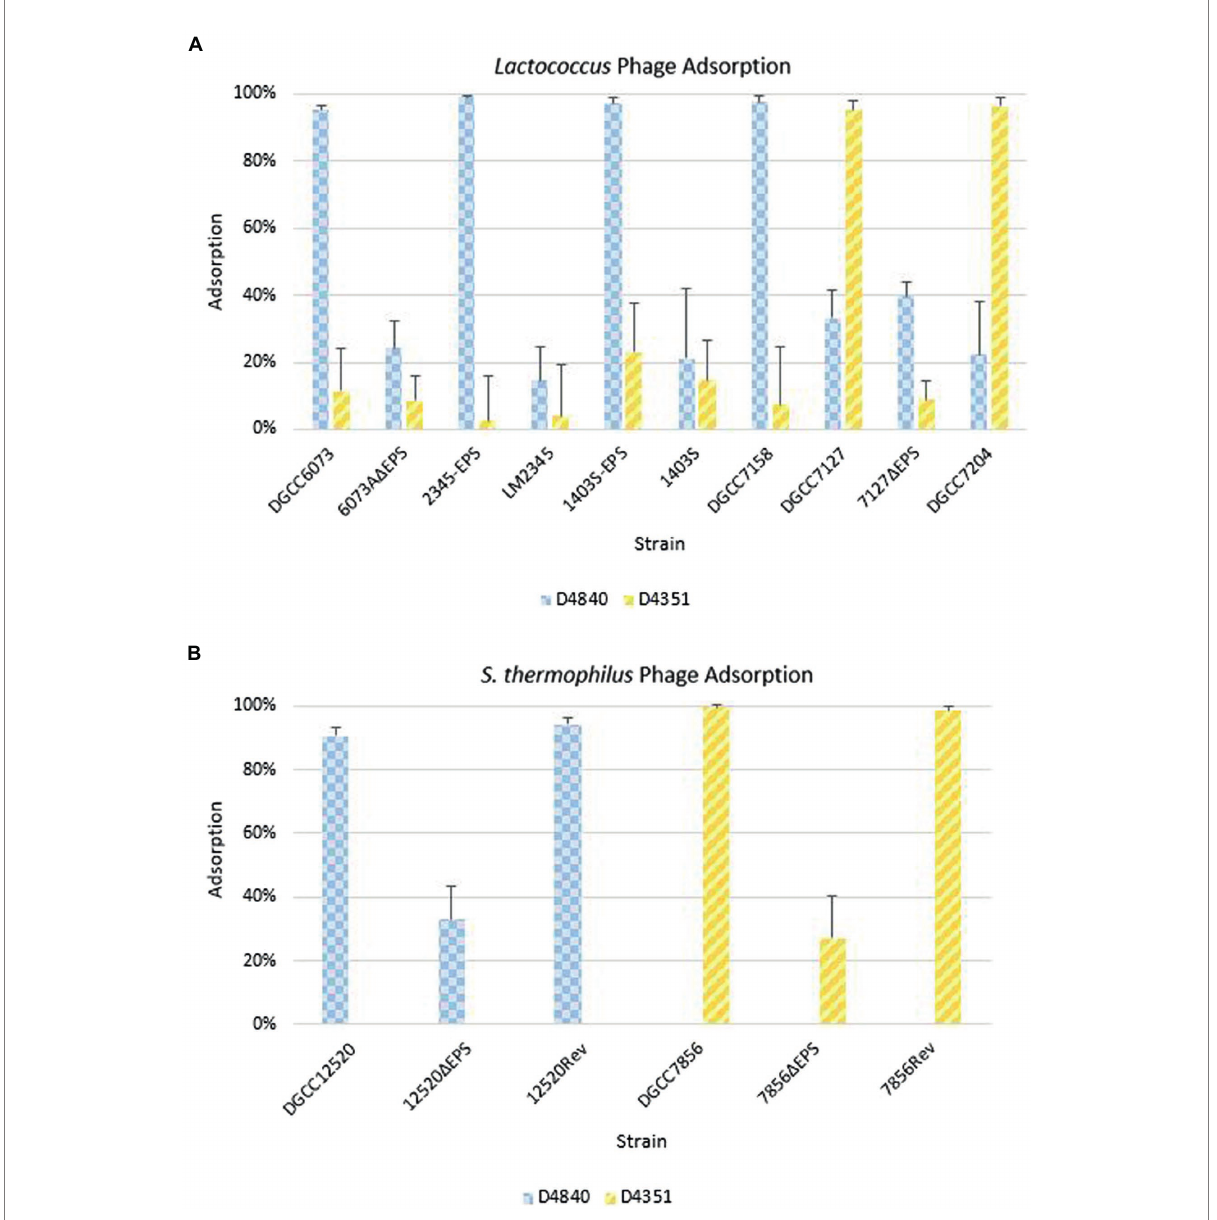
FIGURE 5 Phage adsorption on representative strains including isogenic strain pairs (+/ − EPS). Average of three independent trials. Error bars = sample SD. (A) Adsorption on Lactococcus strains. (B) Adsorption on Streptococcus thermophilus